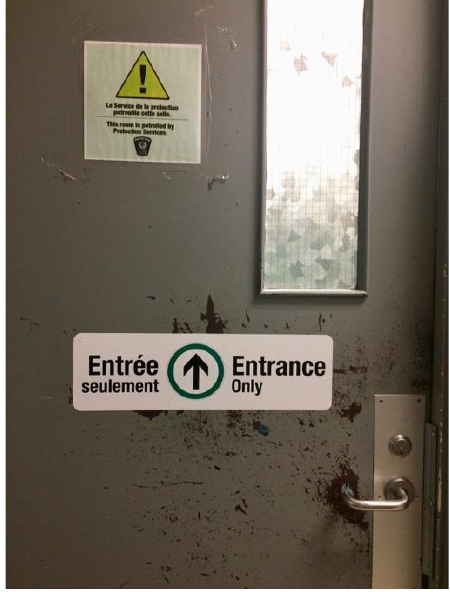
Figure 6. Door leading to the multifaith space in the Student Union building.